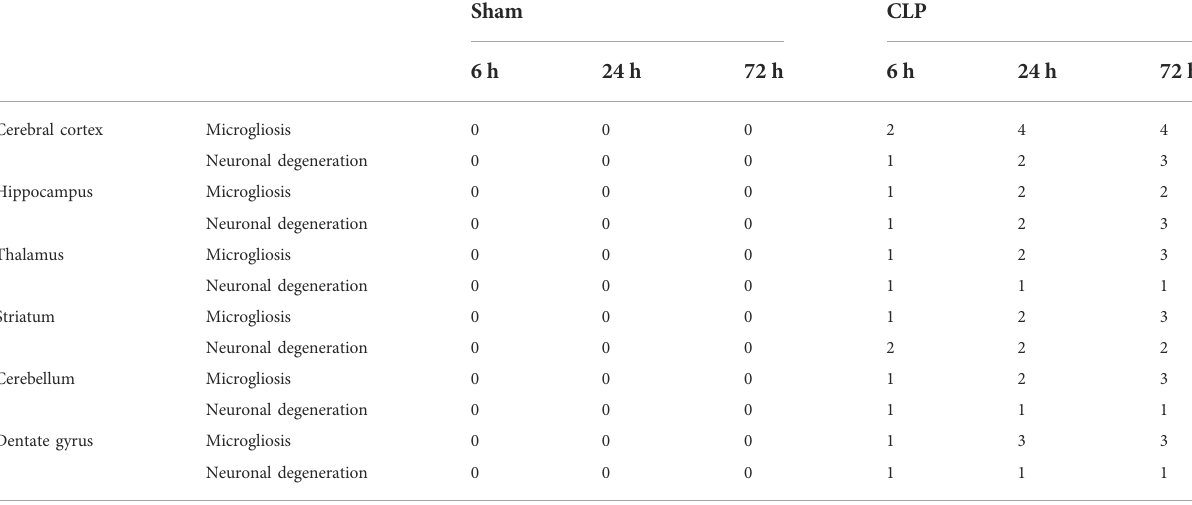
TABLE 2 H & E scoring of the cerebral cortex, hippocampus, thalamus, striatum, cerebellum, and dentate gyrus after 6, 24, and 72 h of subjection to sham and cecal ligation and puncture (CLP).